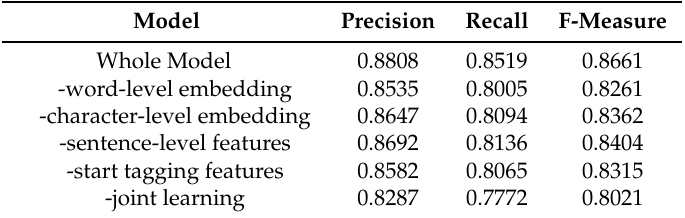
Table 6. An ablation study on the test